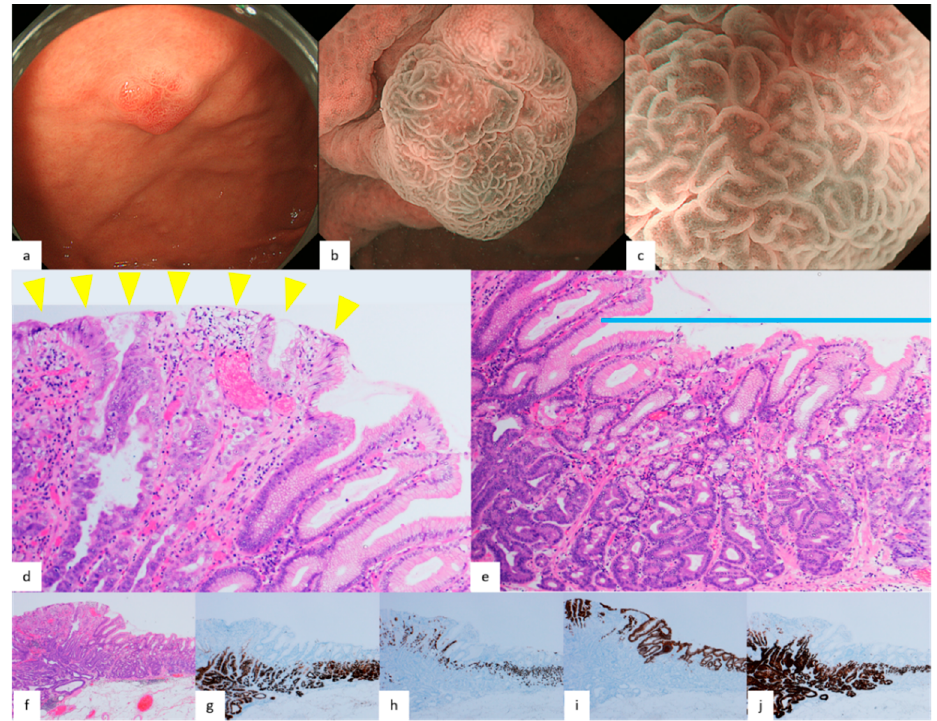
Figure 5. Endoscopic and pathological findings of GA-FGM that with M-NBI diagnosis was non- cancerous. ( a ) WLI. A reddish elevated lesion with SMT-like elevation, 15 mm in size, was noted, and the leading edge of the elevation showed a whitish color; ( b , c ) M-NBI. There was no distinct DL, but dilatation of CO and IP was observed. An arcuate MS without distinct irregularity was also noted, and no MV was visible. An absent MV pattern plus regular MS pattern without a DL were observed by the MESDA-G; the lesion was diagnosed as non-cancerous; ( d ) HE stain. Differentiated adenocarcinoma with low-grade atypia differentiating into a foveolar epithelium-like structure was seen in the surface layer (yellow arrowhead); ( e ) HE stain. In some parts, the surface layer was covered by non-neoplastic mucosa (blue bar), and the component of fundic gland-type adenocarcinoma was seen in the middle and deep layers of the mucosa; ( f ) HE stain; ( g – j ) Immunostain; ( g ) pepsinogen-I (chief cell). Positive in the middle and deep layers; ( h ) H+/K+-ATPase (parietal cell). Positive in the middle layer; ( i ) MUC5AC (gastric foveolar epithelial cell). Positive in the surface layer; ( j ) MUC6 (gastric mucous neck cell). Positive in the middle and deep layers; (( a , c ) cited from Ueyama et al. gastric adenocarcinoma of fundic gland mucosa type (adenocarcinoma). The Atlas of Upper Gastrointestinal Endoscopic Diagnosis (Tokyo) 2020: